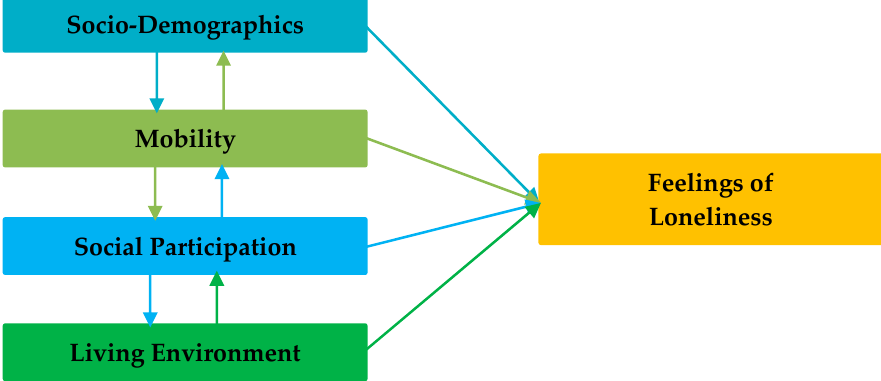
Figure 1. Conceptual model: Factors influencing loneliness in the aging population.